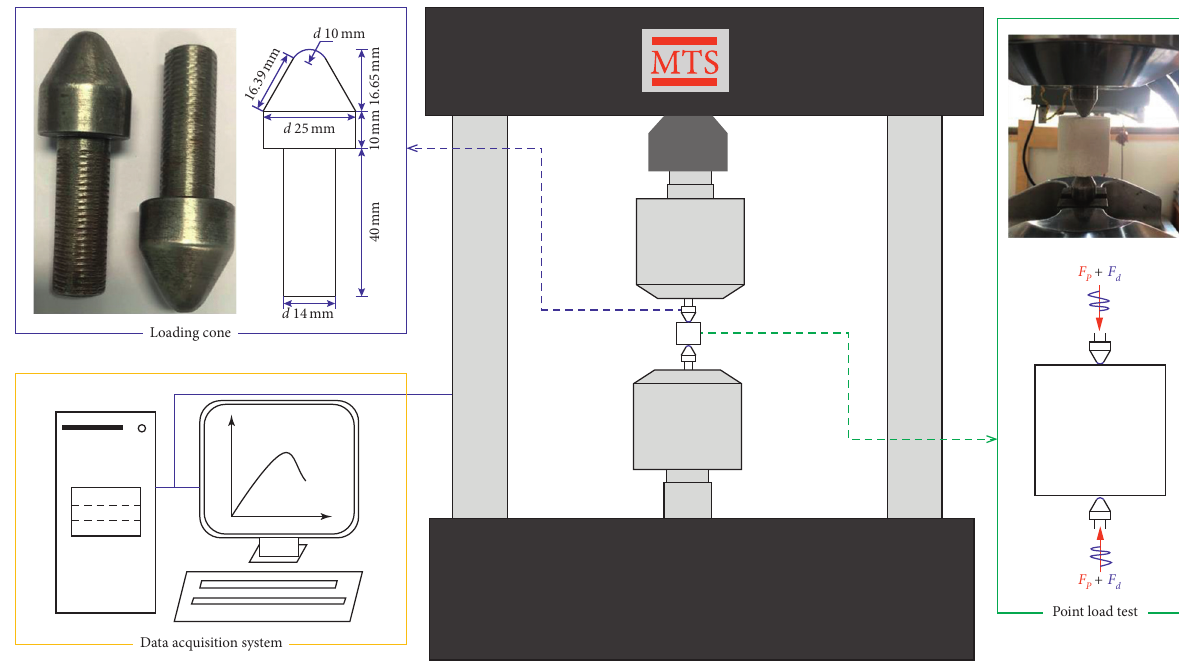
Figure 3: Test equipment.